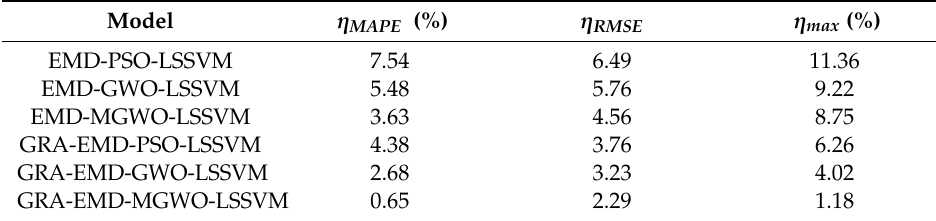
Table 8. Comparison of di ff erent prediction